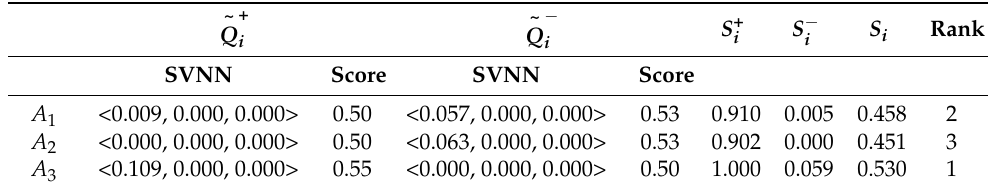
Table 11. Computational details and ranking order of considered GCDs.